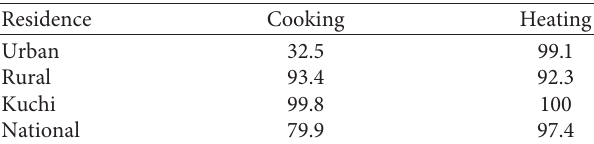
Table 1: Afghan population using solid fuels for cooking and heating [1,